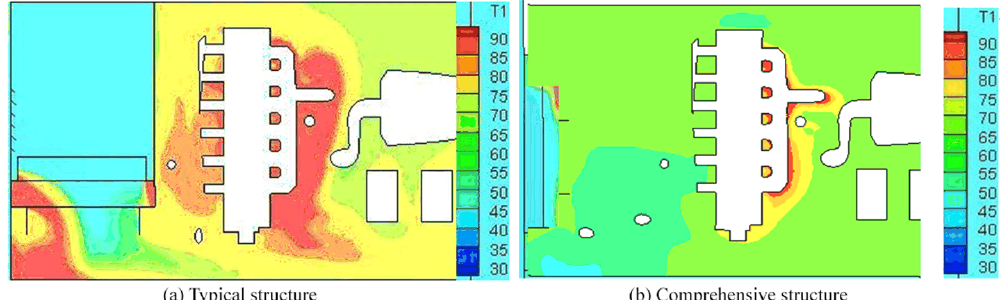
Figure 12. Comparison of temperature fields within the plane Z = 475mm (unit: ◦ C).